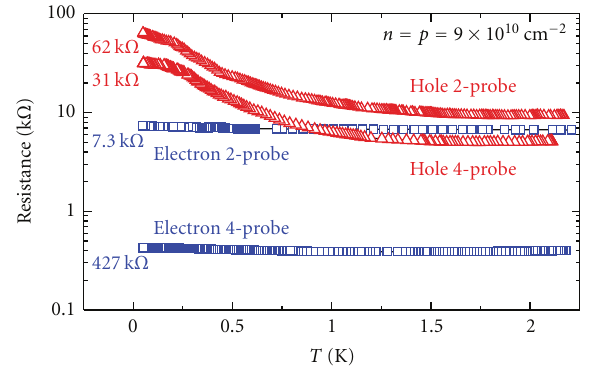
Figure 17: Two-probe and four-probe resistance of the electron (blue squares) and hole (red triangles) layers versus temperature, at n = p = 9 × 10 10 cm − 2 . (Device: B138/C4-1-10nm